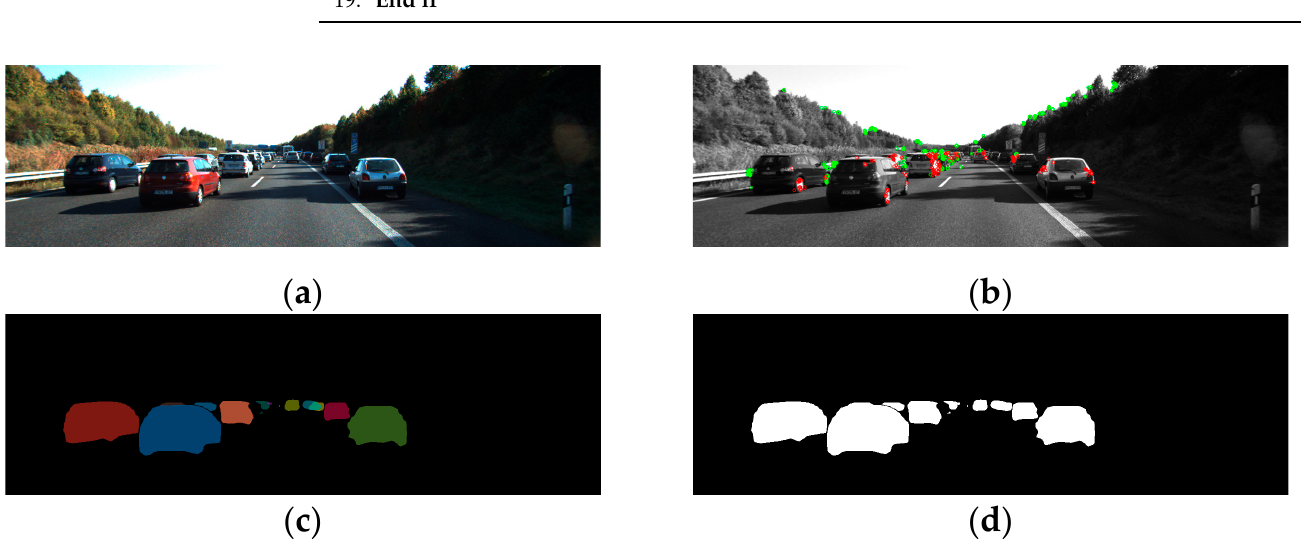
Figure 2. Dynamic region recognition in images. ( a ) Original input image. ( b ) Dynamic feature point detection. ( c ) Semantic segmentation boundary box. ( d ) Dynamic region segmentation results.